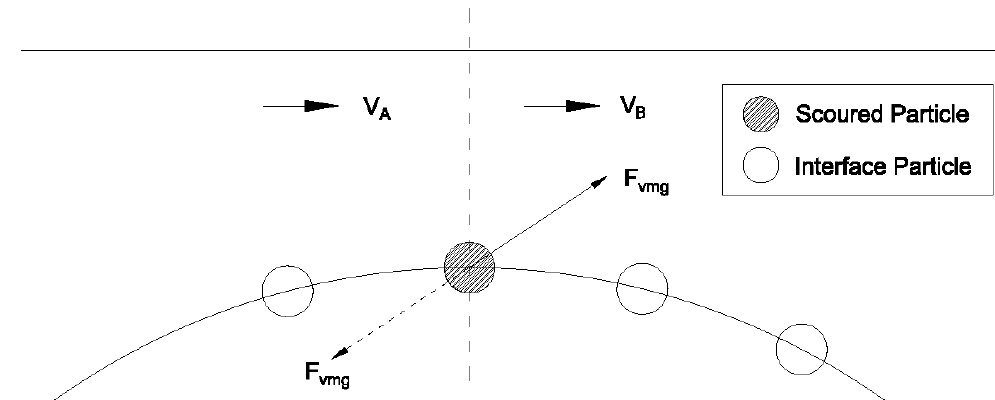
Figure 3. Particle initiation process in response to the fluid velocity.